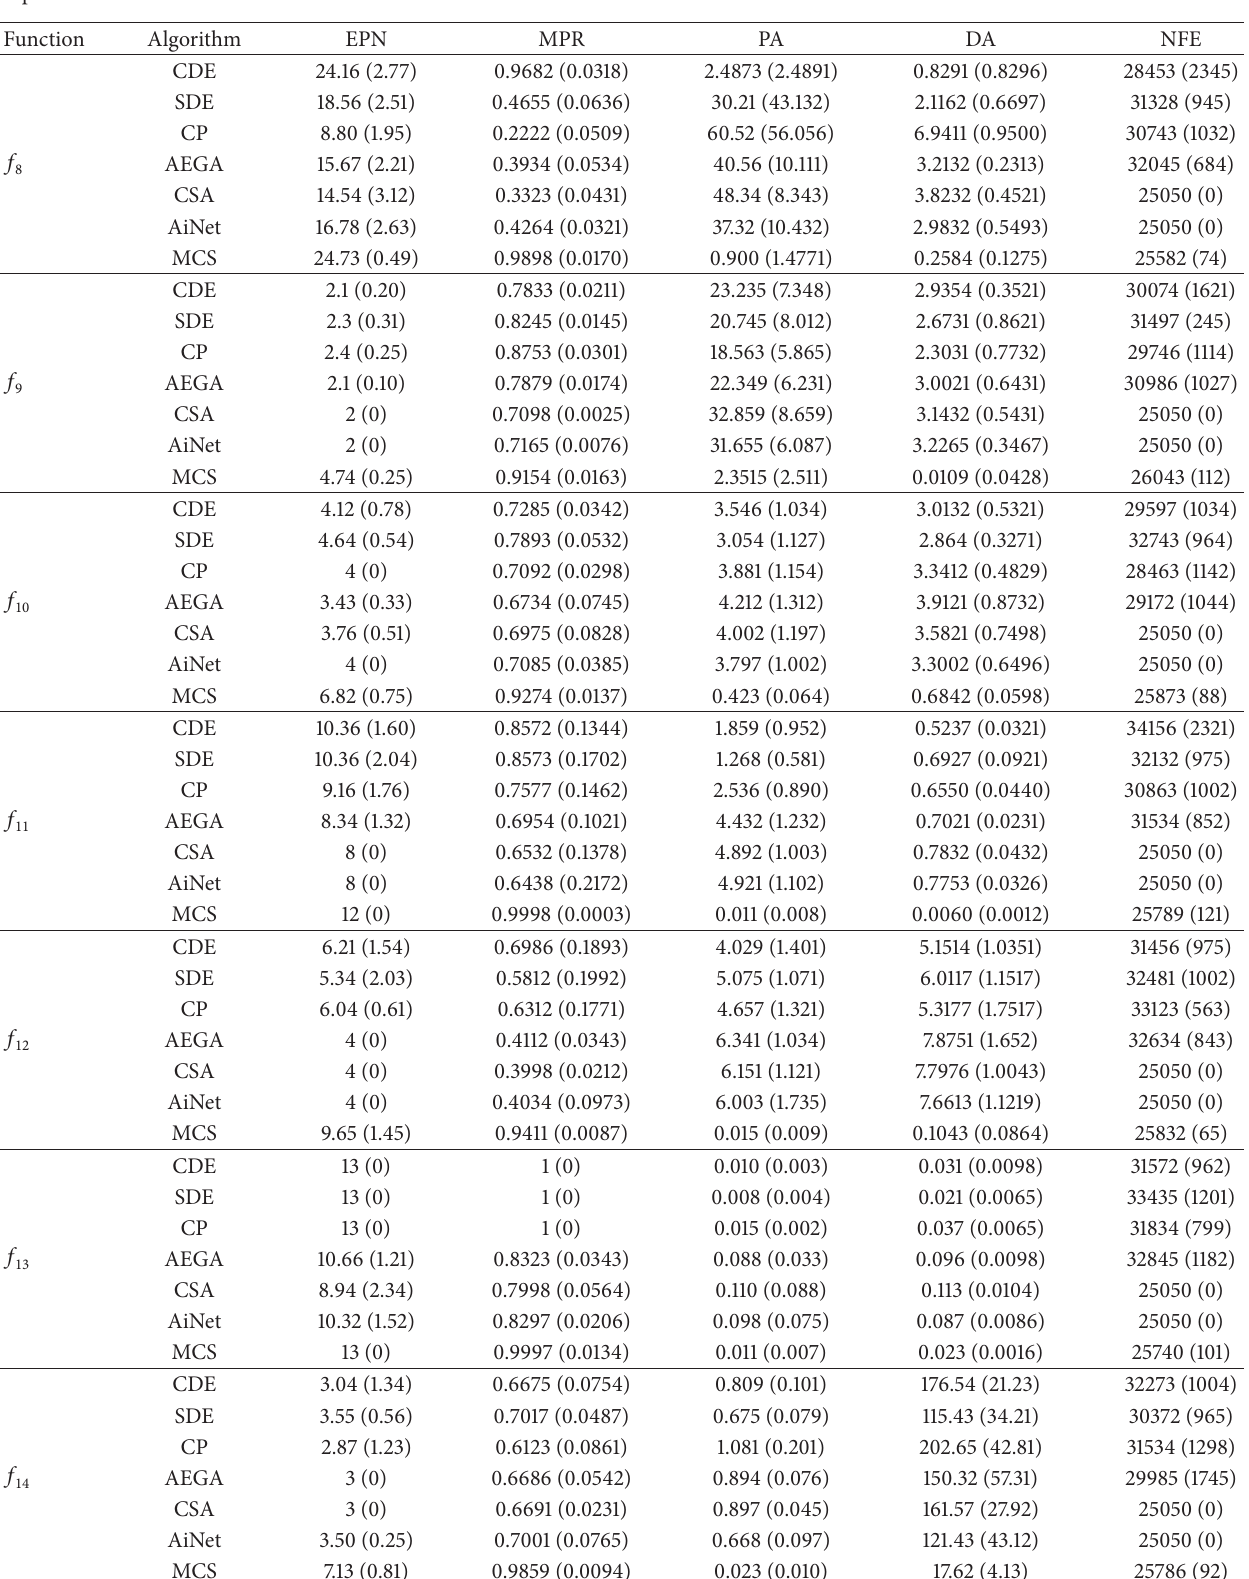
Table 2: Performance comparison among multimodal optimization algorithms for the test functions 𝑓 8 – 𝑓 14 . For all the parameters, numbers in parentheses are the standard